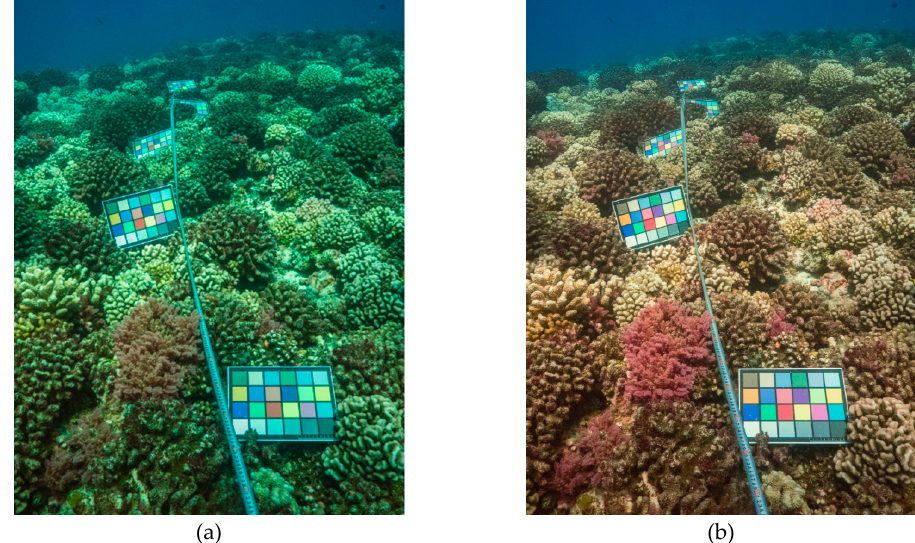
Figure 9. Tests for underwater color reproduction. ( a ) Original image, ( b ) color-corrected image.